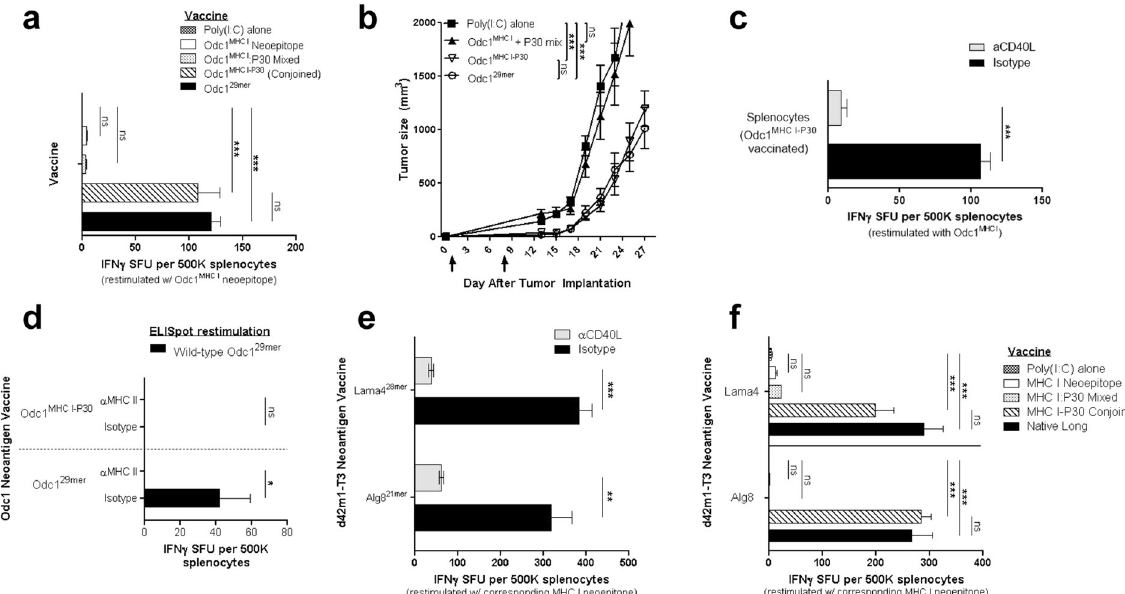
Fig. 2 Conjoined P30 can effectively supplant the endogenous helper epitope within highly immunogenic neoantigen vaccines. a IFN γ ELISpot: mice ( n = 3) were immunized with poly(I:C) alone, Odc1 MHC I , Odc1 MHC I mixed with the P30 helper epitope, Odc1 MHC I conjoined to the P30 helper epitope, or the Odc1 29 mer SLP. Seven days later, the splenocyte response to Odc1 MHC I was evaluated. One-way ANOVA with post hoc Tukey ’ s test. b Subcutaneous SMA560 tumor growth in mice ( n = 7) following therapeutic immunization on days 1 and 8 with poly(I:C) alone, Odc1 MHC I mixed with P30, Odc1 MHC I conjoined to P30 (Odc1 MHC I-P30 ), or the Odc1 29 mer SLP. c IFN γ ELISpot: splenocyte response to Odc1 MHC I 7 days following immunization with the Odc1 MHC I-P30 SLP in the context of CD40L-blocking antibody